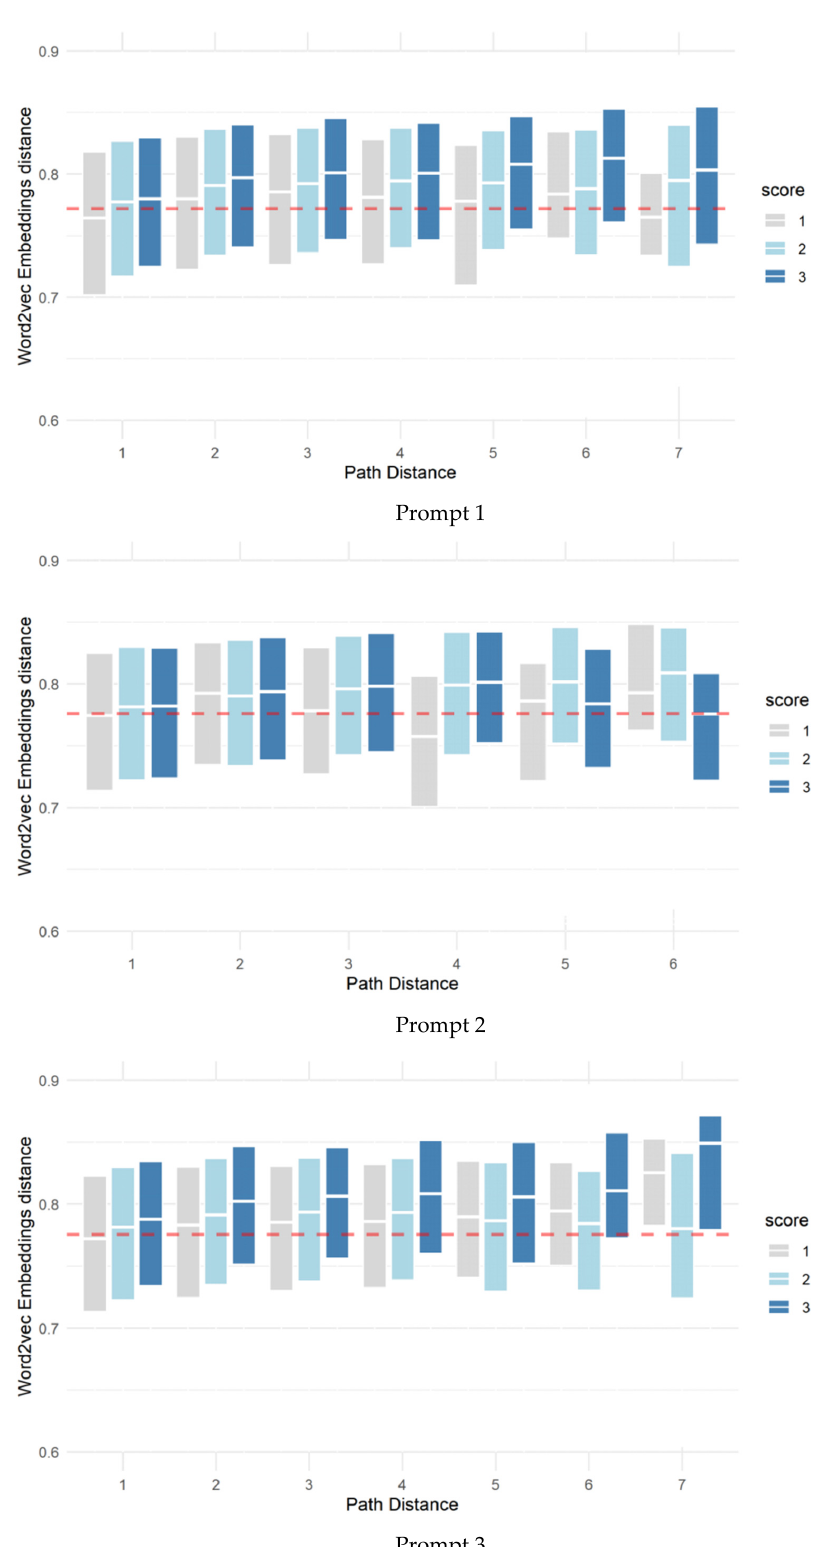
Figure 3. Semantic distance and path distance distribution cross over originality scores depicted at the level of essays. The x -axis indicates path distance, while the y -axis indicates the semantic distance calculated based on word2vec embeddings. The bands correspond to the inference representing 95% of the density interval for the given score point. The horizontal lines in the boxes indicate the mean semantic distance between the nodes for the given score point.